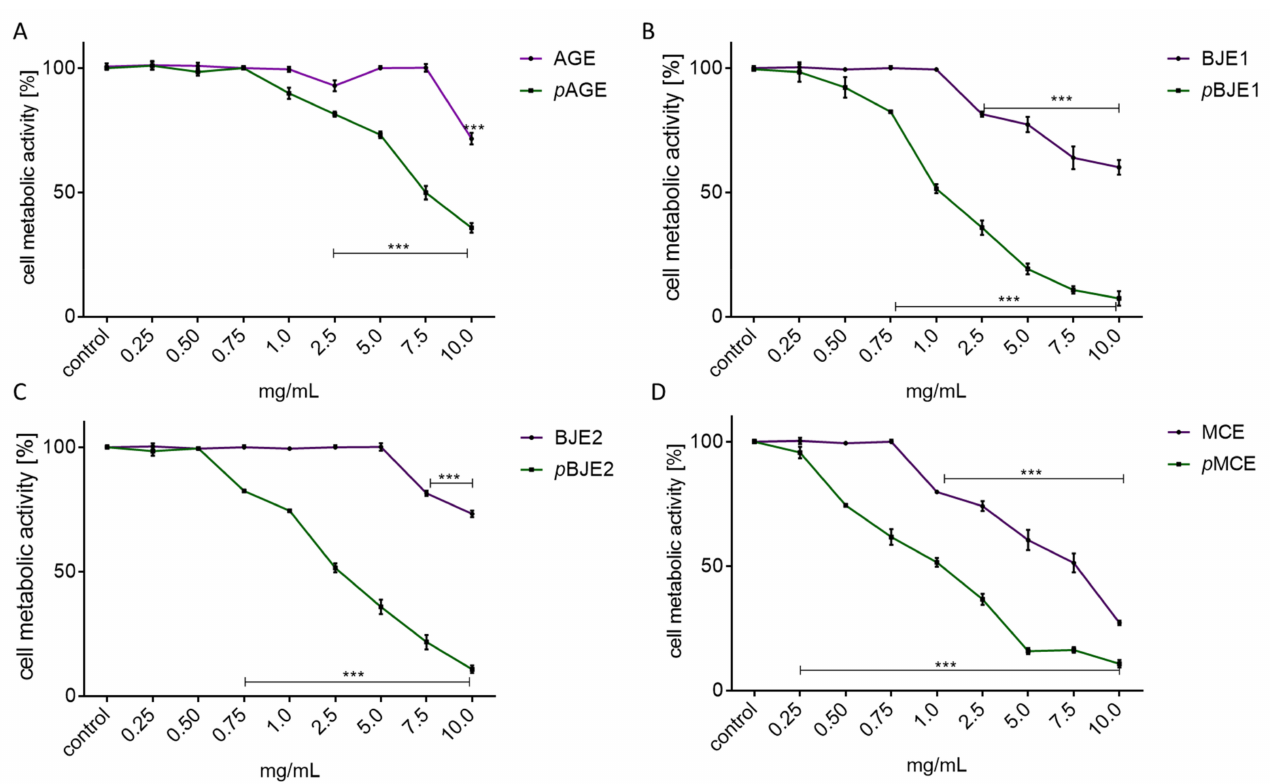
Figure 1. The influence of extracts ( Apium graveolens , AGE) ( A ), leaf mustard 1 ( Brassica juncea 1, BJE1) ( B ), leaf mustard 2 ( Brassica juncea 2, BJE2) ( C ) and chamomile ( Matricaria chamomilla , MCE) ( D ) on Caco-2 cells’ metabolic activity after their 24-h incubation with ethanolic extracts and the SPE-purified extracts (p) at 0.25–10 mg/mL concentration; control cells were not exposed to any compound except vehicle; values are means ± standard deviations from at least three independent experiments, n ≥ 9; statistical significance was calculated versus control cells (untreated) with *** p ≤ 0.001. Table 1. The IC 0 concentration values for the extracts determined with PrestoBlue assay after 24-h incubation of Caco-2 cells. Extract AGE pAGE BJE1 pBJE1 BJE2 pBJ2 MCE pMCE IC 0 [mg/mL] >2.50 0.75 2.00 0.25 2.50 0.75 >2.50